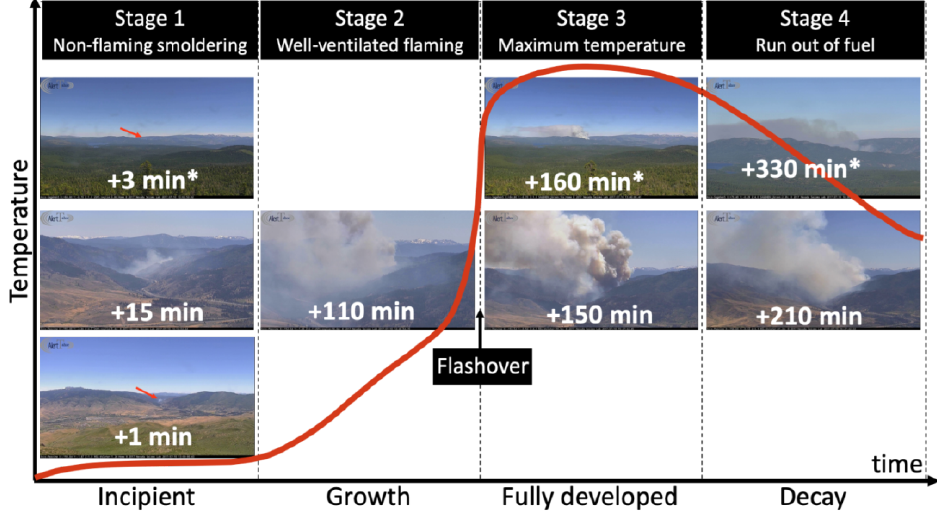
Figure 3. The 4 stages of fire. The example shown is the Farad Fire of July 2017 observed from two different cameras (Peavine fire camera and * Sage Hen Fire